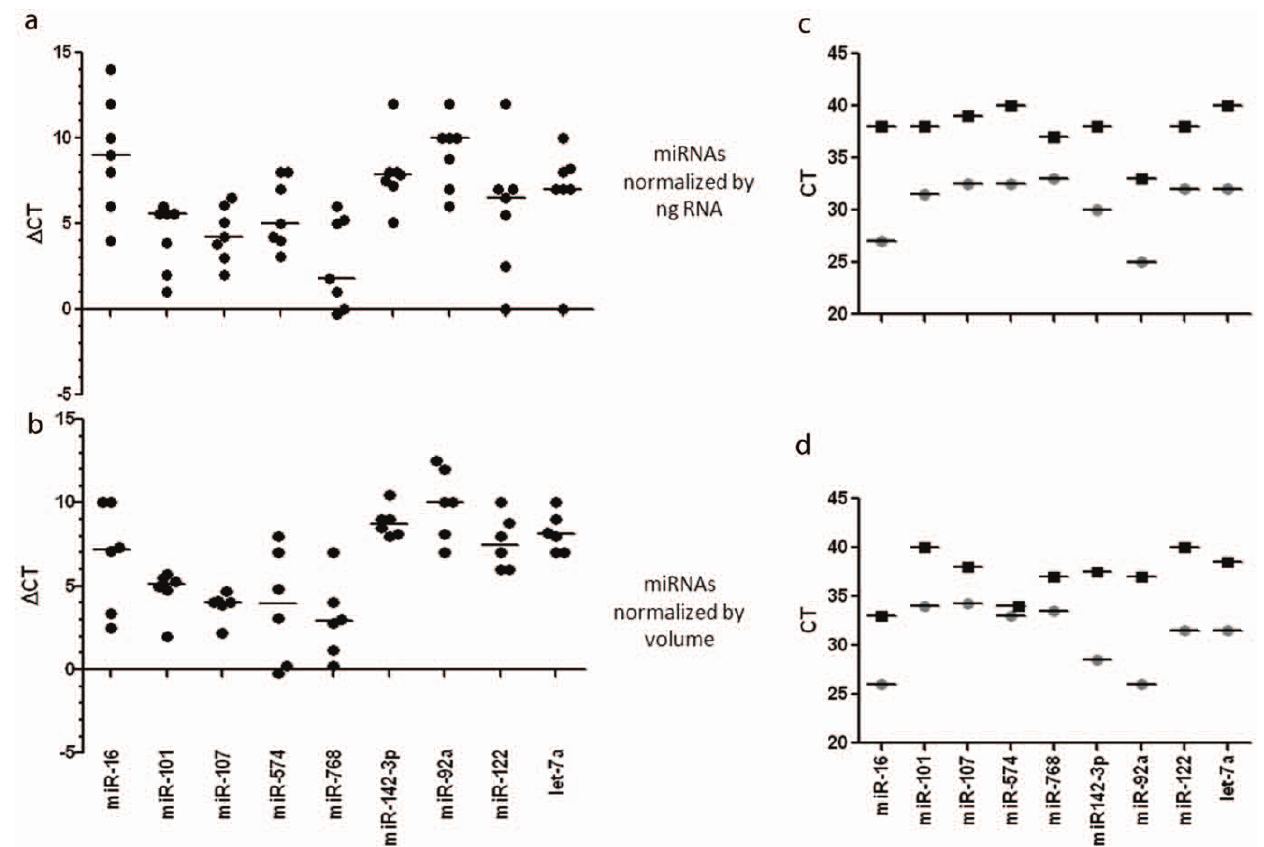
Figure 2. Serum miRNAs are predominantly in exosomes. The relative expression of microRNAs extracted from exosome-depleted supernatant or exosomes was expressed as the difference in threshold cycle number between the exosome depleted supernatant and the exosome pellet ( D Ct: Ct supernatant – Ct exosome pellet). A 1 unit difference in D CT represents a two-fold difference in the amount of input miR. Positive numbers show higher concentrations in the exosomes whereas negative numbers indicate higher concentrations in the exosome-depleted supernatant. The absolute difference between the two can be calculated as 2 D CT . The RNA included in the qPCR reaction was normalized to either equal amount ( a ) or equal volume ( b ) of RNA. Panels ( c ) and ( d ) show the absolute differences in microRNA levels amplified from serum exosome pellet ( # ) and exosome-depleted supernatant ( % ).